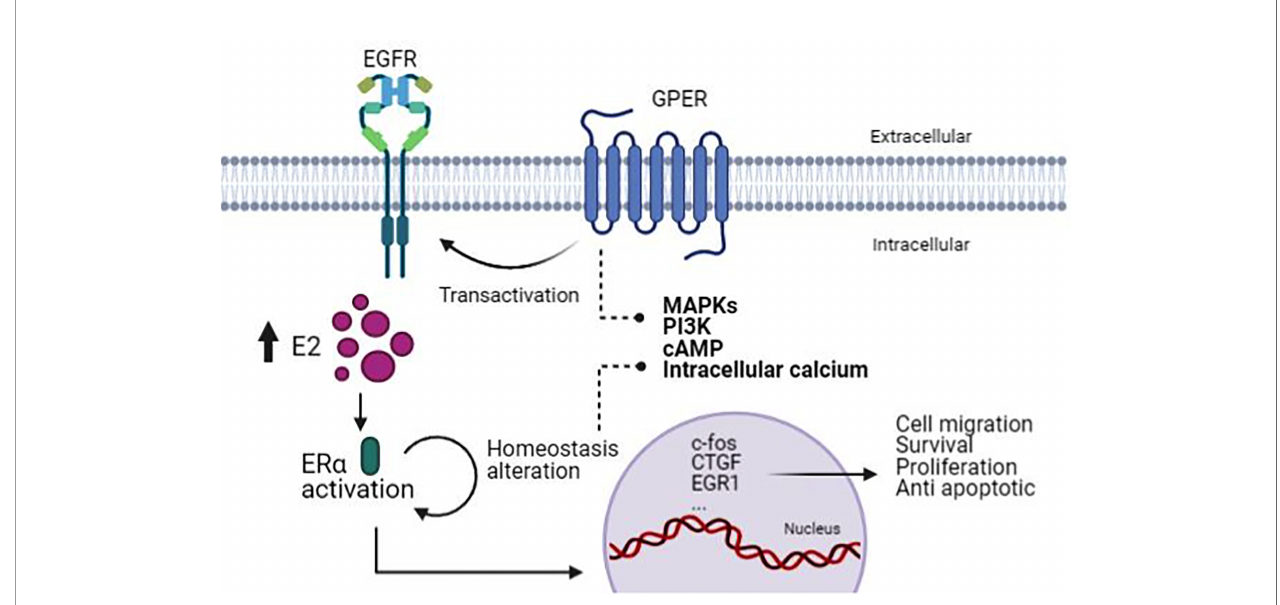
FIGURE 2 | The mechanism associated with ER and GPER in PCa. Due to the increasing activity of ER a , this brings about homeostasis alteration that GPER transactivates EGFR, causing activation of pathways involved in cell migration, survival, proliferation, and anti-apoptotic process. (Figure created with